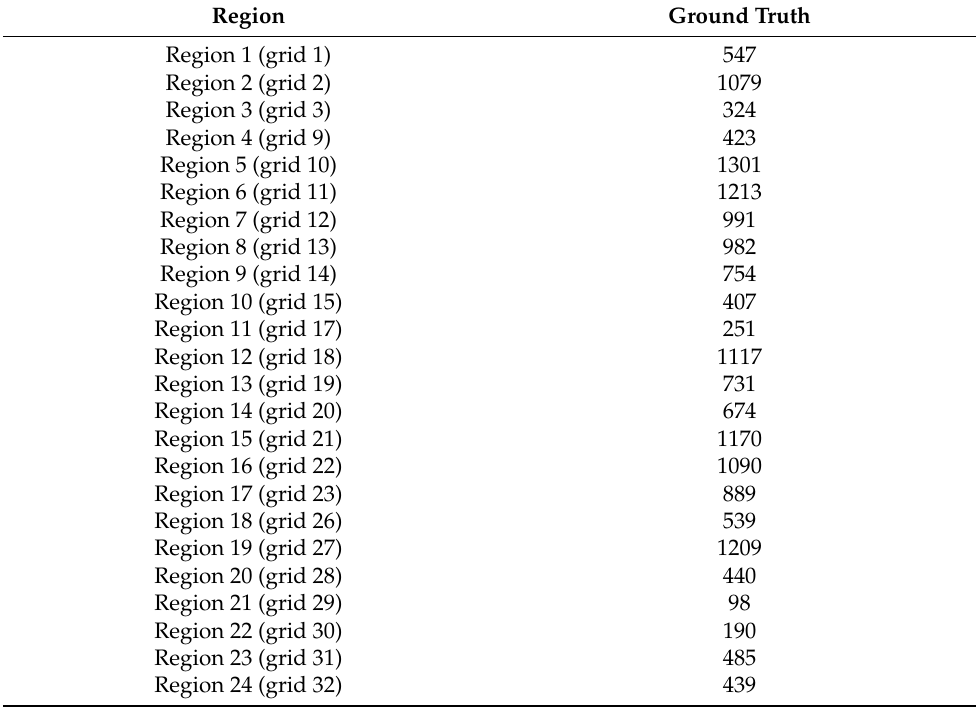
Table 9. Oil palm tree detection testing